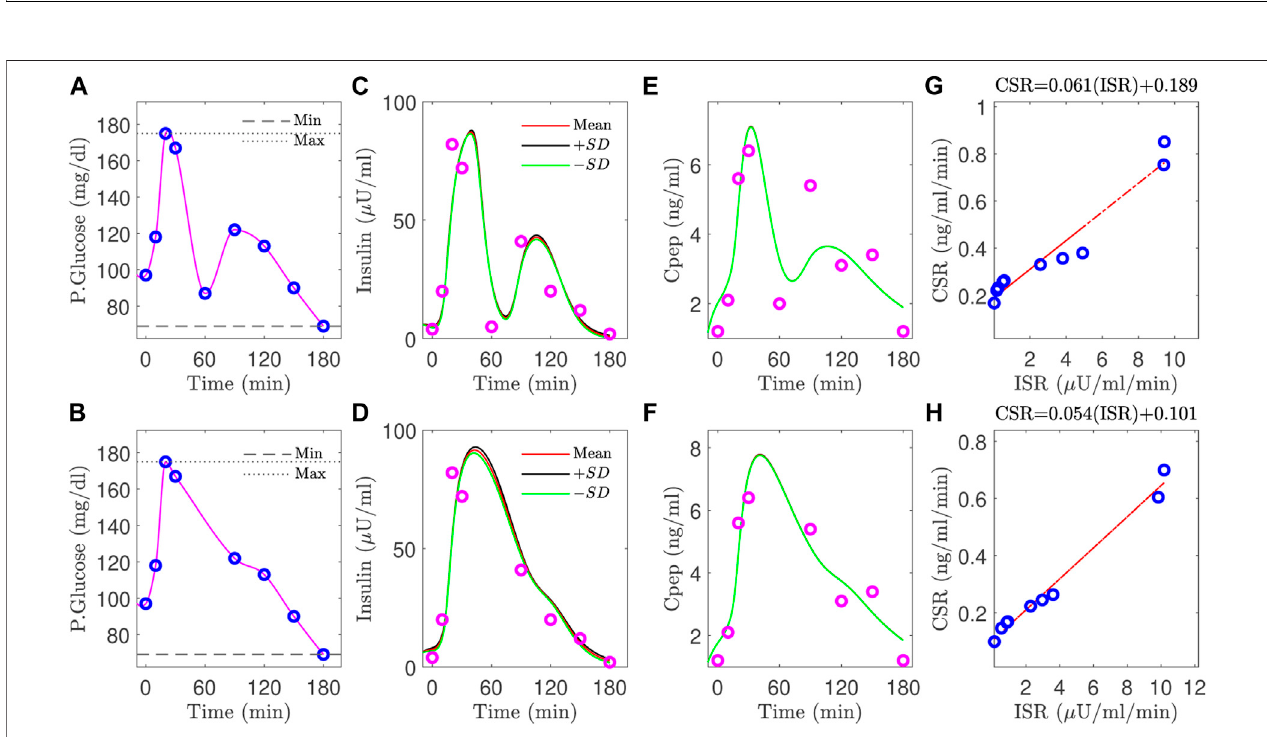
FIGURE6| Improvementfortheestimationresultsofplasmainsulin( (D) versus (C) ),c-peptide( (F) versus (E) ),andslope( (H) versus (G) )byremovingtheuncertain blood glucose value at 60 min (A) , and using the interpolated glucose values in the gap between the glucose values at 30, 90 min (B) .